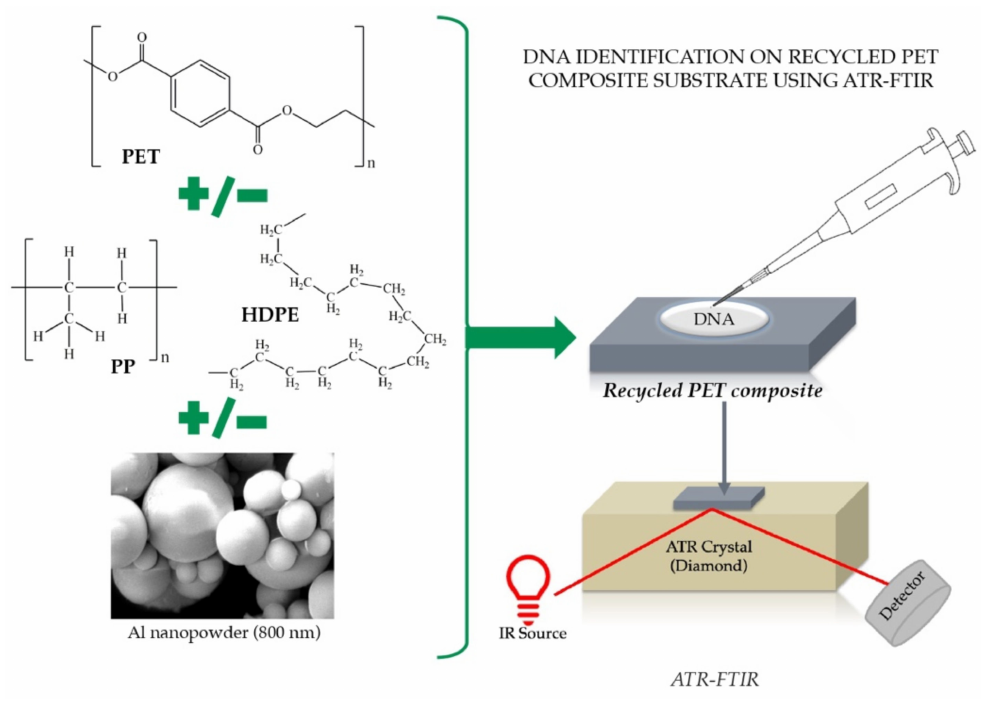
Figure 1. DNA identification on recycled PET composites—workflow .